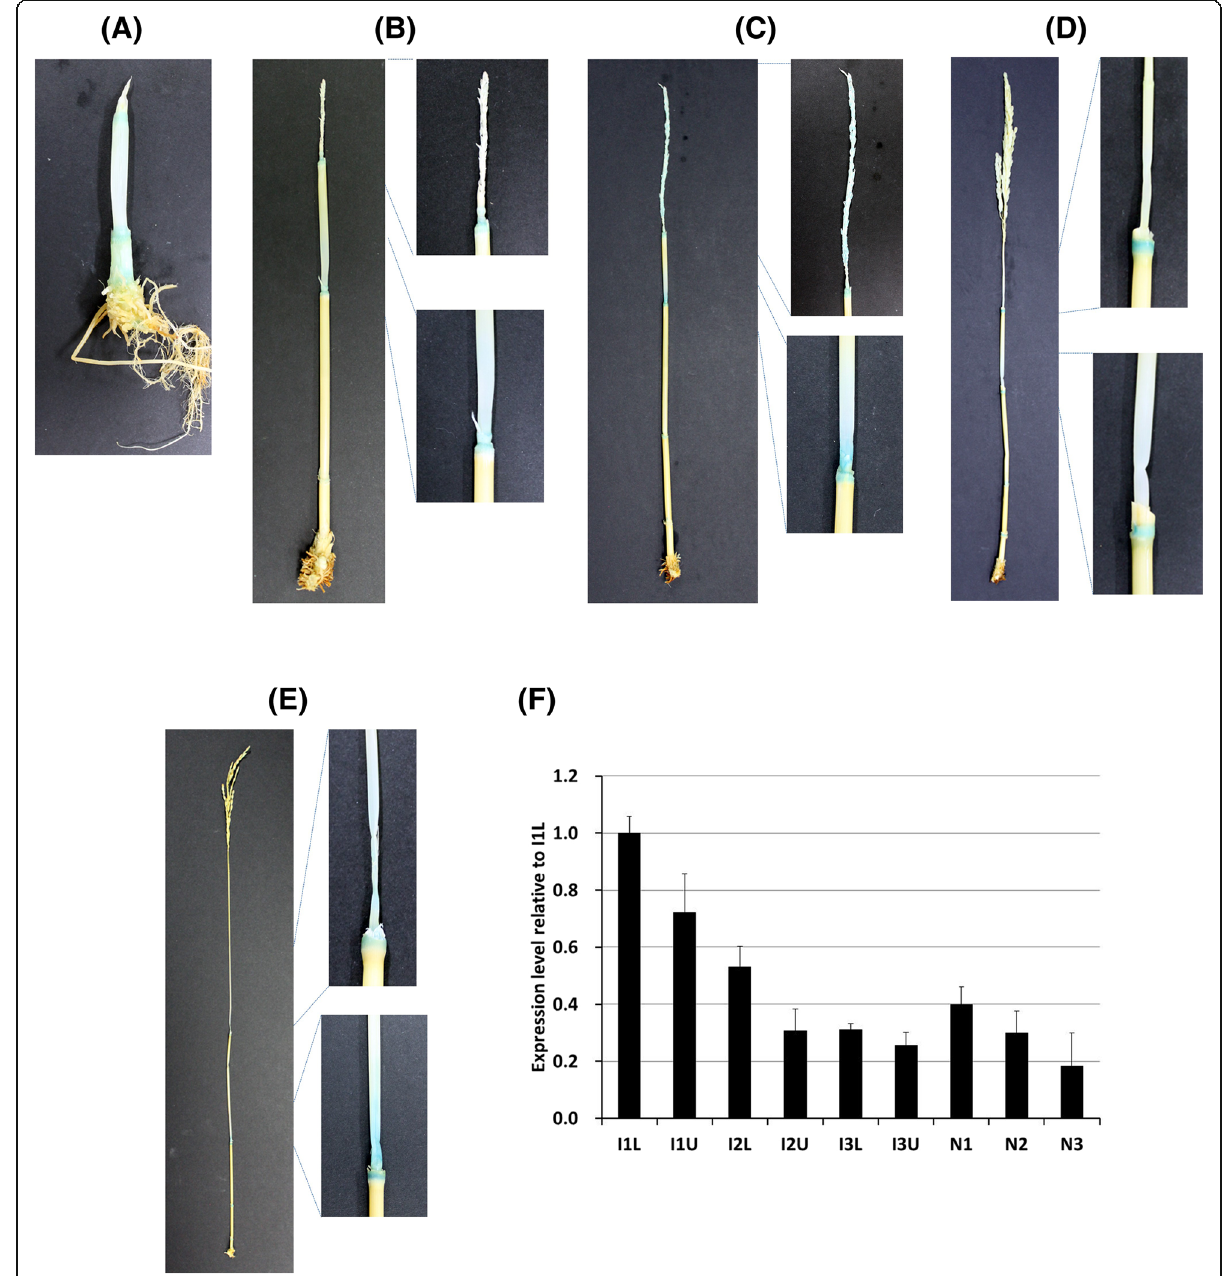
Fig. 5 GUS expression pattern of SNB promoter:GUS fusion gene transgenic lines. ( a ) Culm of rice plant when panicle length was 0.6 cm. ( b ) Culm of rice plant when panicle length was 3.5 cm. ( c ) Culm of rice plant when panicle length was 12.4 cm. ( d ) Culm of rice plant when panicle length was 17.7 cm. ( e ) Culm of rice plant when panicle length was 20.8 cm (heading stage). ( f ) Results of qRT-PCR analysis of the SUI4 gene in the culm of a heading stage plant. I1L: lower half of the first internode, I1U: upper half of the first internode, I2L: lower half of the second internode, I2U: upper half of the second internode, I3L: lower half of the third internode, I3U: upper half of the third internode, N1: first node, N2: second node, N3: third